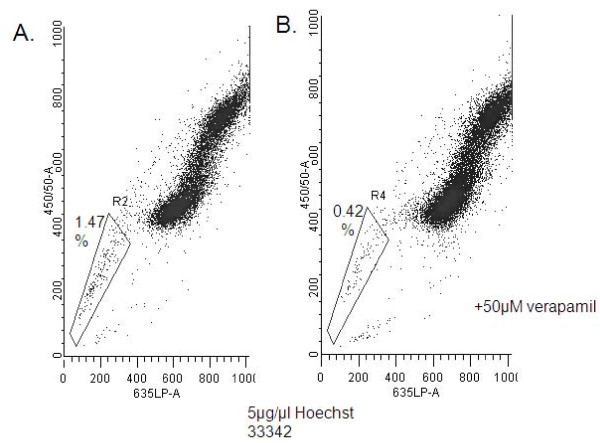
SP in RC-58T/hTERT/SA#4-D cells. A) RC-58T/hTERT/SA#4-D cells were analyzed for SP based on Hoechst 33342 (Sigma) or DCV staining. The RC-58T/hTERT/SA#4-D SP cells represent 1.47% of the entire population. B) 0.42% of the RC-58T/hTERT/SA#4-D SP as inhibited by 50 μM verapamil.